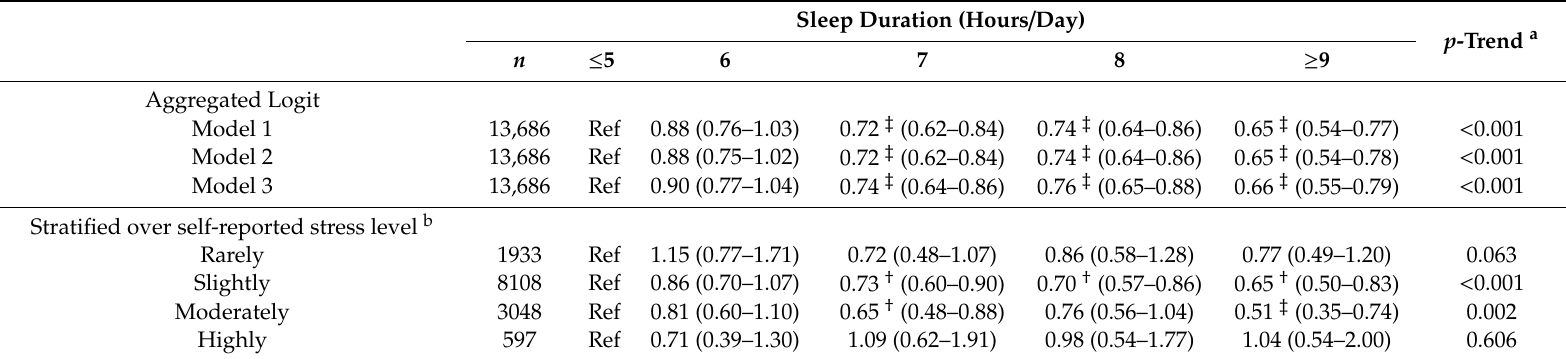
Table 3. Adjusted odd ratios and 95% confidence intervals a for abdominal obesity according to sleep duration with the e ff ect of